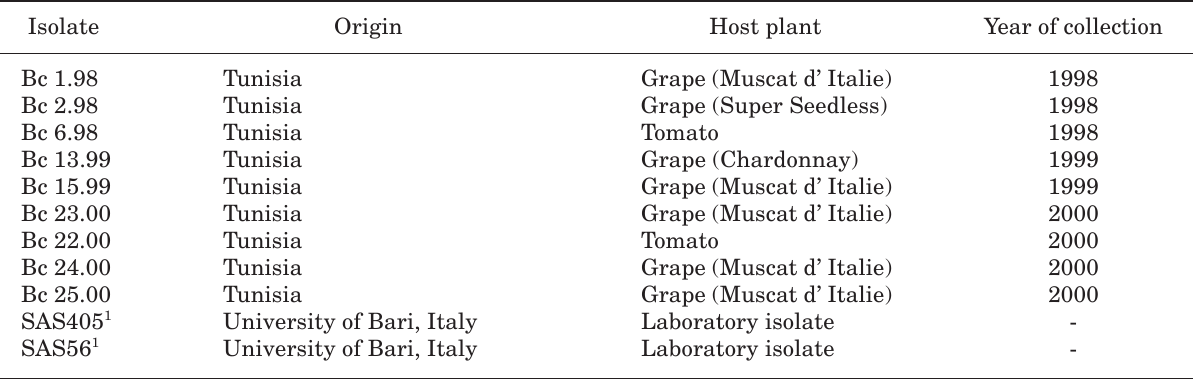
Table 1. Characteristics of a subset of Botrytis cinerea isolates used in this study to test for transposons: origin, host plant and year of